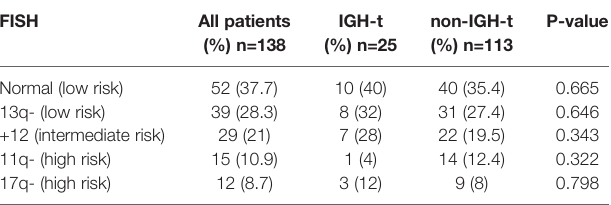
TABLE 1 | Concomitant FISH results of all patients and those in the IGH-t and non-IGH-t